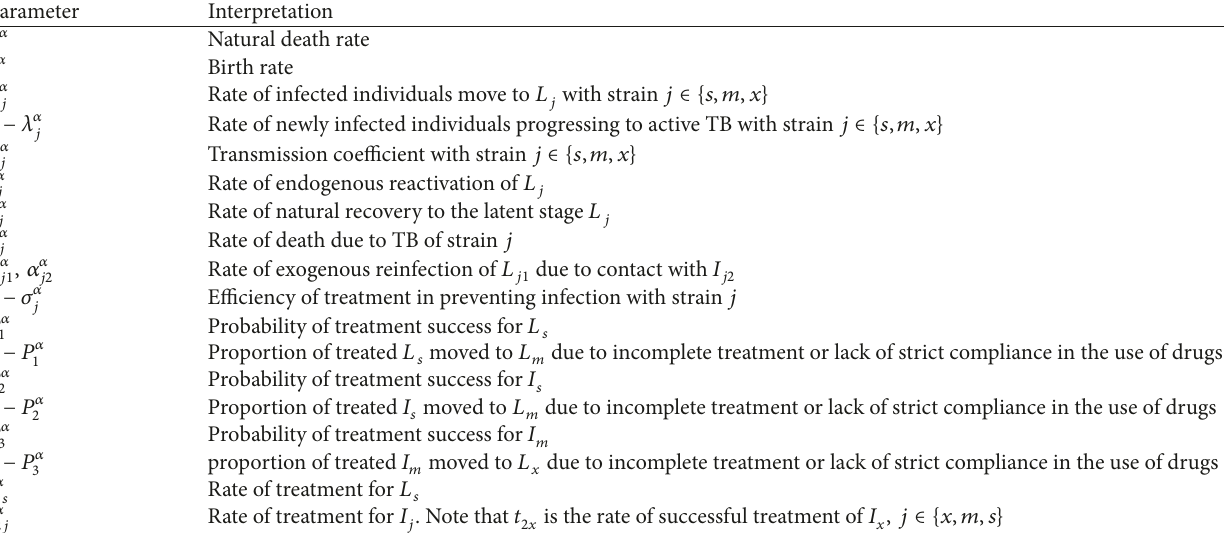
Table 2: All adapted parameters and their interpretation of system